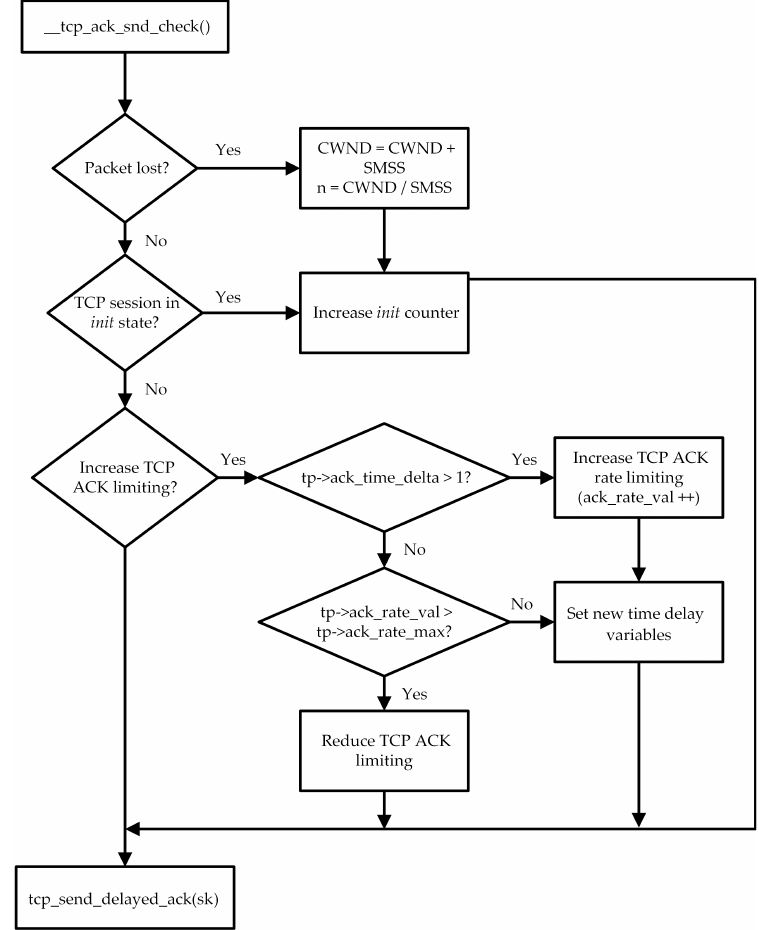
Figure 1. Acknowledgment rate limiting